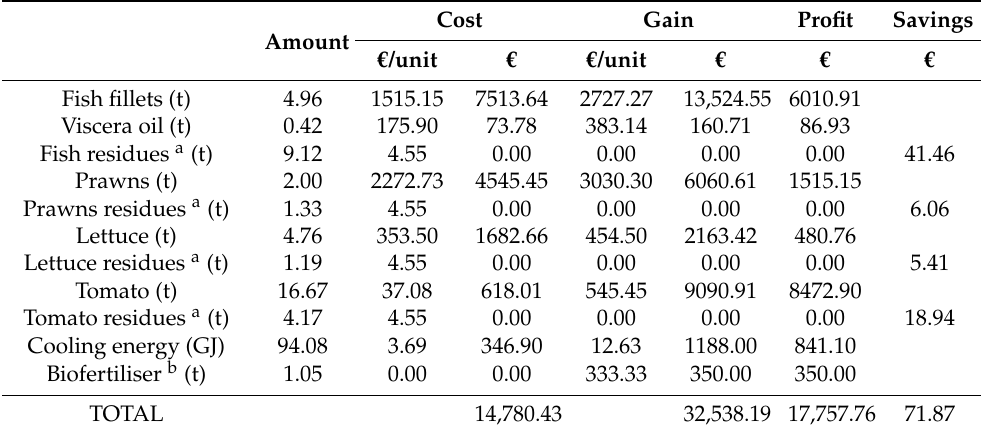
Table 4. Cost-gain balance from the PISCIS production considering the outputs from biogas produc- tion facility (monthly